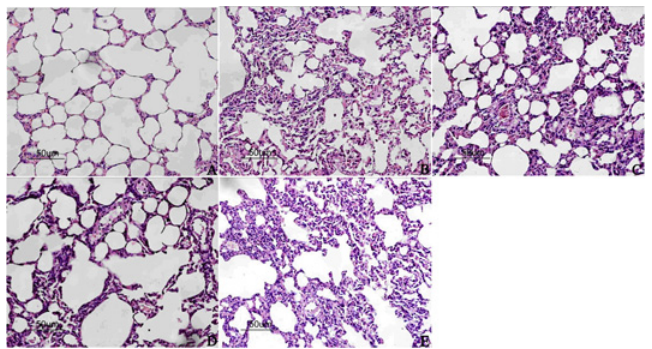
Figure 3. H&E staining of lung tissue (×200 magnification). A: Sham group; B: I/R group; C: IPO group; D: Levo group; E: Levo+5-HD group.